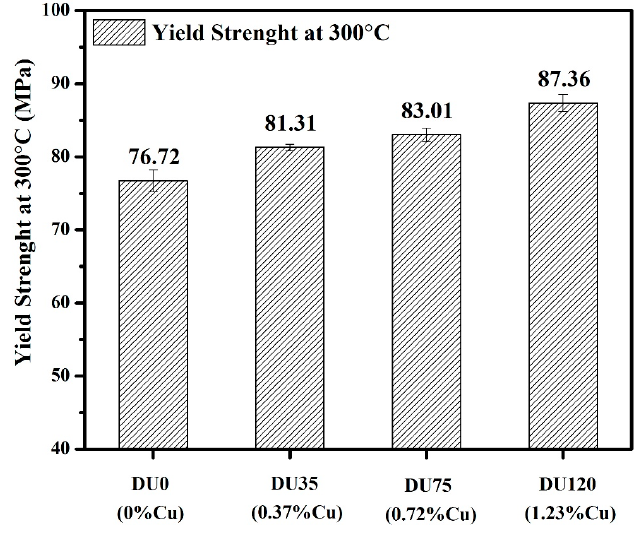
Figure 14. Yield strength at 300 °C of the experimental alloys after the heat treatment at 425 °C/6 h.